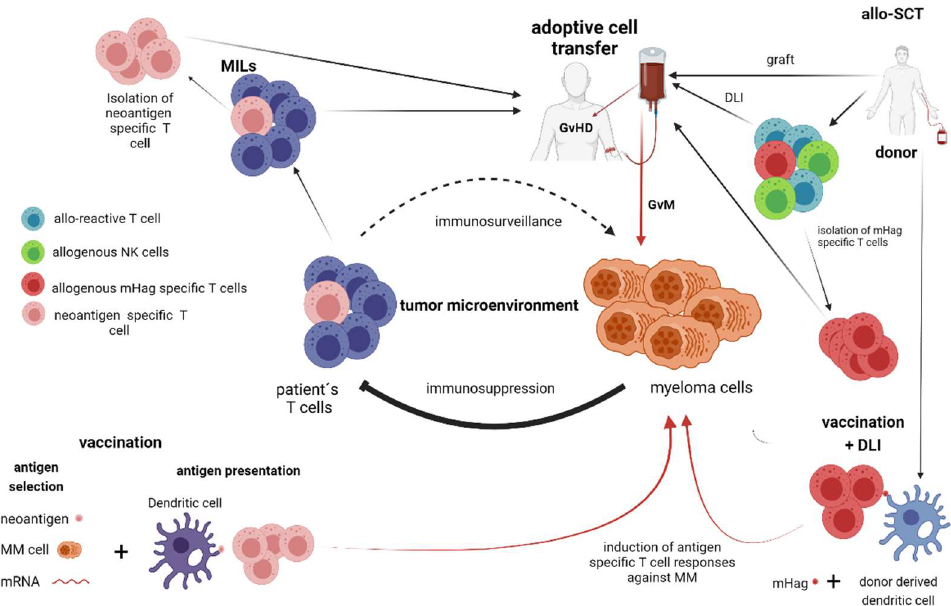
Figure 2. T-cell and NK-cell-dependent therapies without genetic manipulation (allogeneic stem cell transplantation, vaccination strategies, adoptive immune transfer of lymphocytes without genetic manipulation). Allo-SCT: Allogeneic stem cell transplantation; GvM: Graft versus myeloma; IMIDs: immunomodulatory drugs; MILs: Marrow-infiltrating lymphocytes; MDSCs: Myeloid-derived suppressor cells; TAMs: Tumor-associated macrophages; Tregs: Regulatory T cells; mHag: Minor histocompatibility antigen.